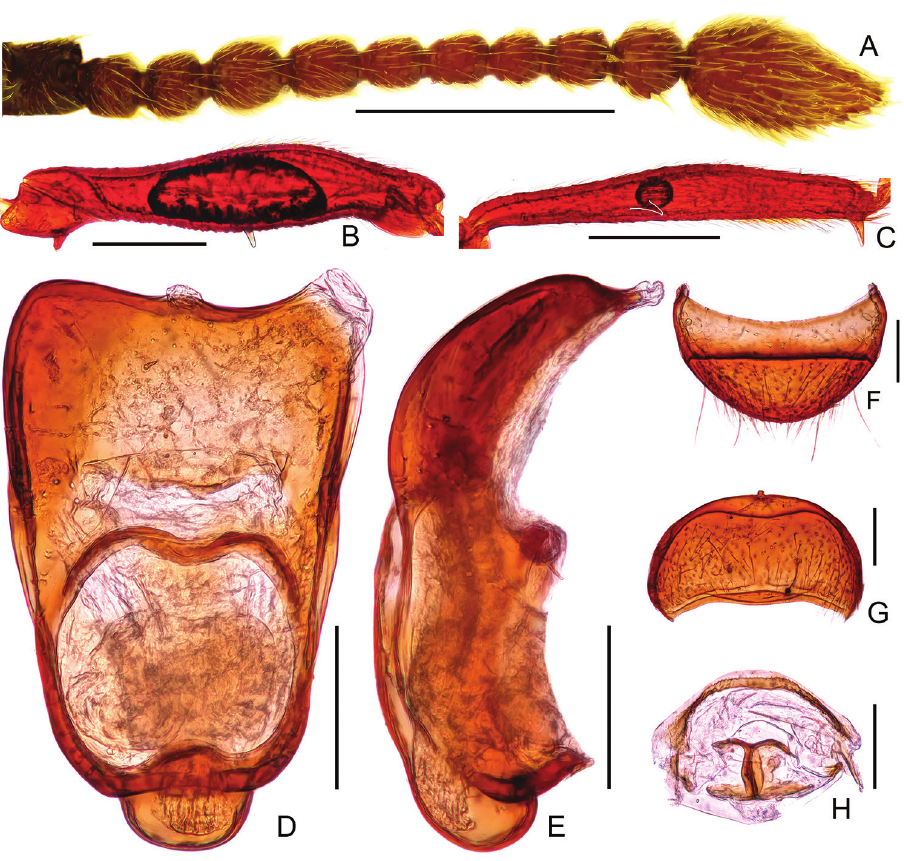
Figure 3. Diagnostic features of Batrisodes grossus ( A–E Male F–H Female). A Antenna B Mesotro- chanter and mesofemur C Mesotibia D–E Aedeagus, in ventral ( D ), and lateral ( E ) views ( F ) Tergite VIII G Sternite VIII H Genital complex. Scale bars: 0.2 mm ( A–C ); 0.1 mm ( D–H Biology. All adults were collected from an Odontomachus colony in a tree hole (Fig. 12). Etymology. The specific epithet refers to the roughly punctate body surface of the new species.